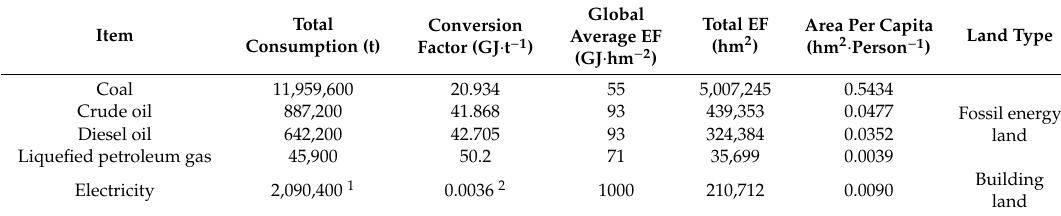
Table 3. Fossil energy footprint account of northwestern Guangxi in 2015.